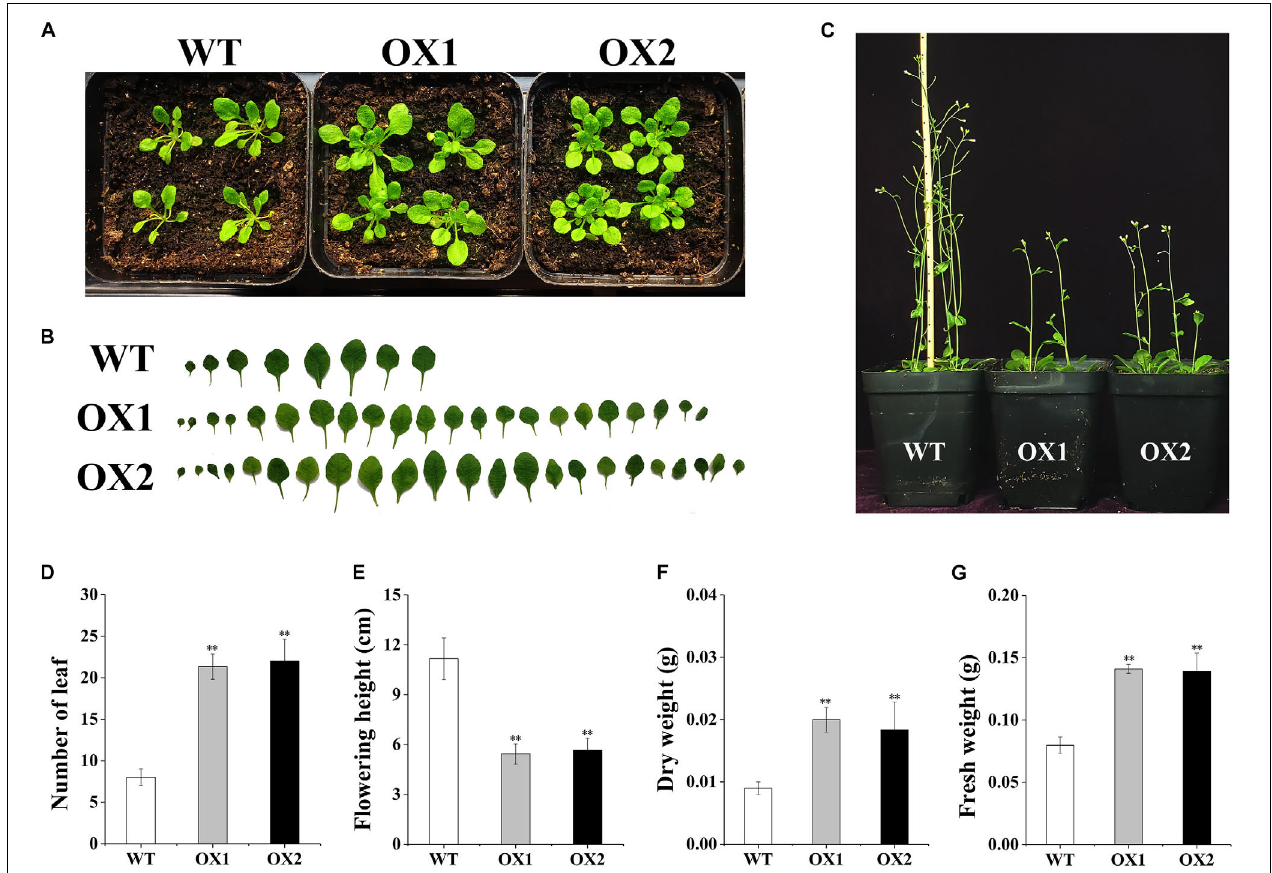
FIGURE 4 | The Comparison of OoNAC72 -OX and wild plants. (A) The plant phenotype of WT and OoNAC72 -OX (OX1, OX2) plants grown under LD conditions after 3 weeks. (B) Schematic diagram of leaves phenotypic analyses of WT and OoNAC72 -OX (OX1, OX2). Results from one of five biological replicates were shown. (C) The plant height of WT and OoNAC72 -OX plants grown under LD conditions after 6 weeks. (D–G) Statistical analysis of WT and OoNAC72 -OX (OX1, OX2) in leaf number, flowering plant height, dry and wet weight. Wet and dry weight in 3 weeks old seedlings test results. Data are represented as mean ± SD of at least three independent replications. Asterisk indicates significant difference ( ∗ P < 0.05; ∗∗ P < 0.01) between transgenic lines and